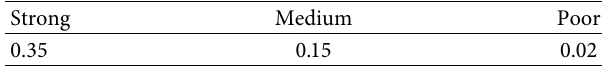
Table 5: Appropriate index of CV Com [6].